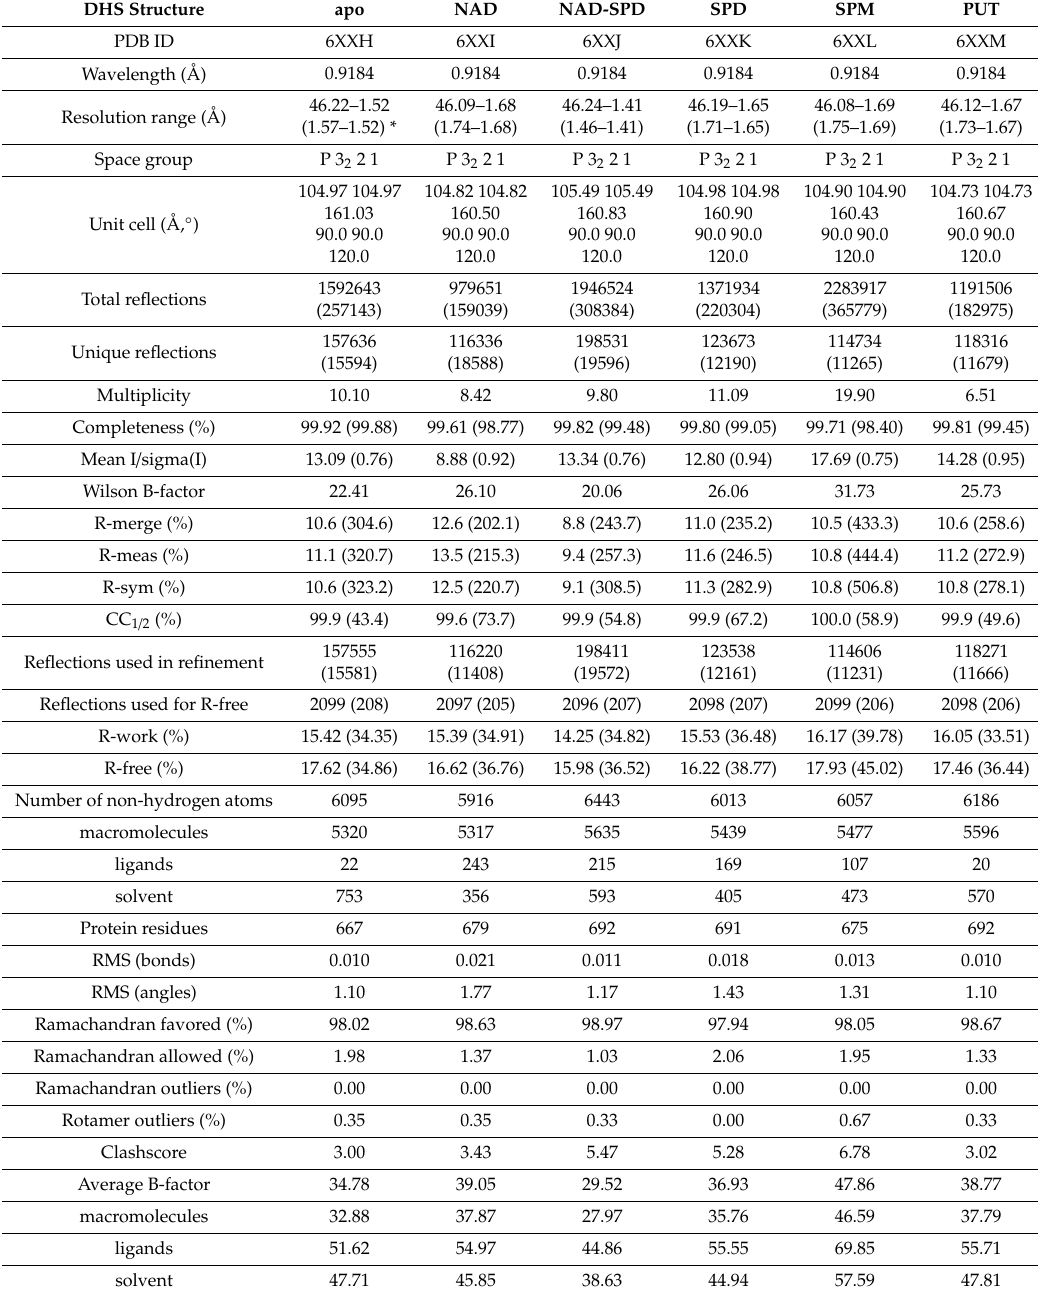
Table 1. Data collection and refinement